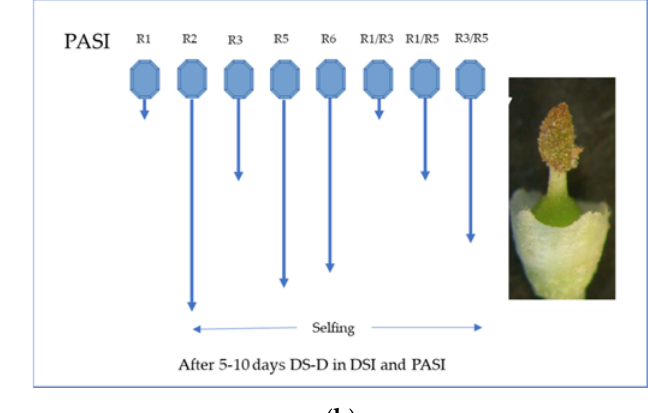
Figure 5. Probability for a variety with a genotype DSI ‐ PASI to match a pollinizer at random in an orchard.